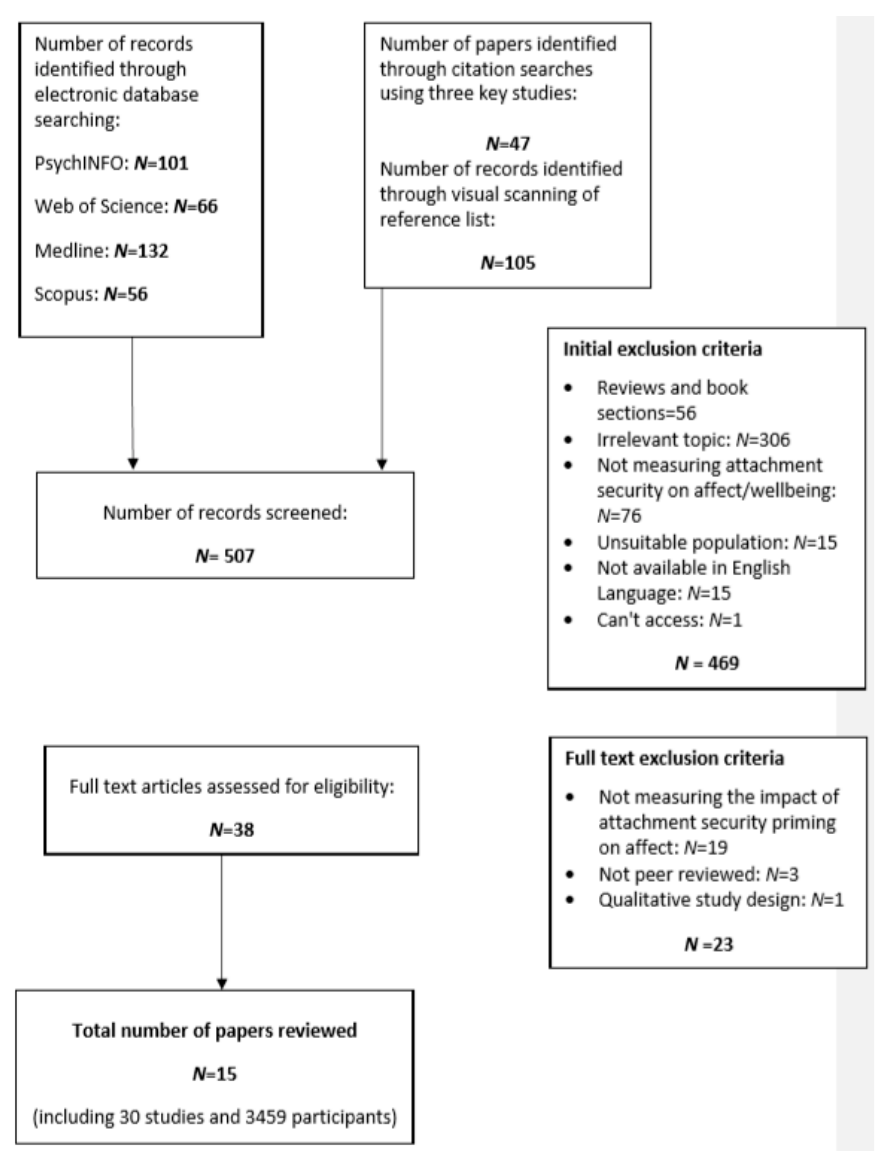
Figure 1. Chart of Search and Retrieval .